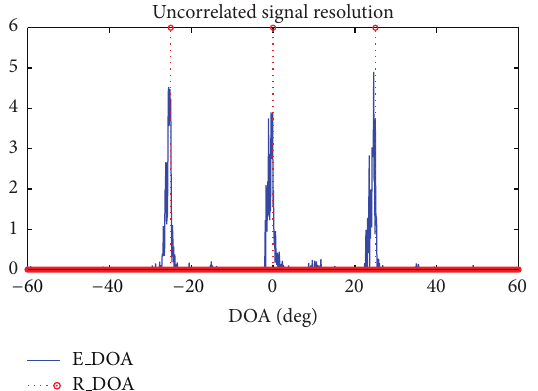
Figure 8: Uncorrelated signal resolution simulation based